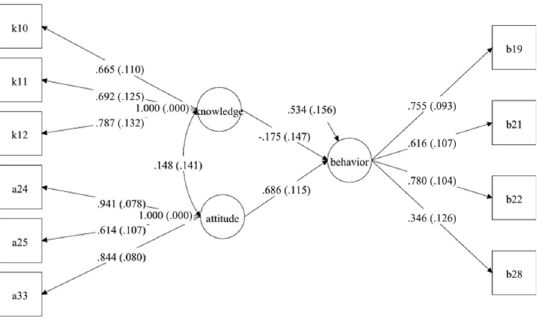
Fig 2. The model of food safety knowledge, attitude and eating